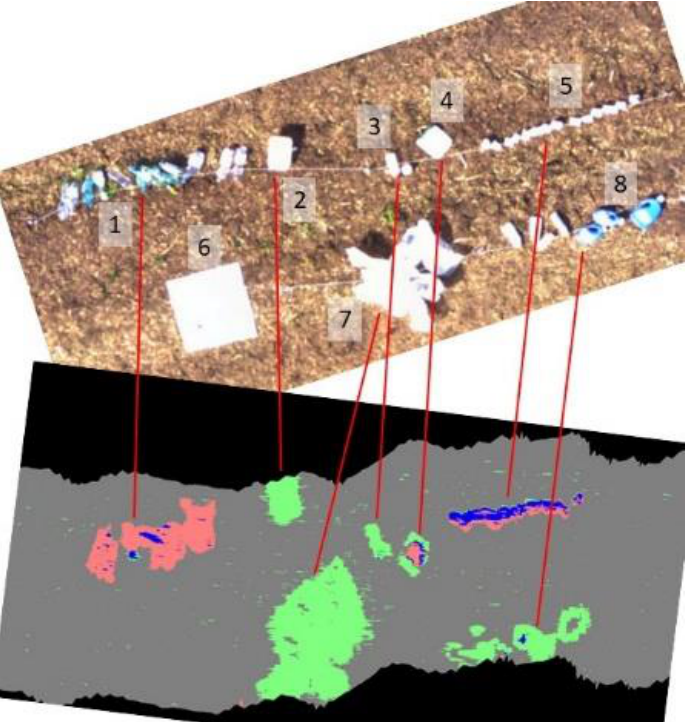
Figure 12. Detection of objects over bare earth: (1) PET bottles; (2) unknown plastics container; (3) Polypropylene (PP) containers; (4) unknown plastics container; (5) PP containers; (6) floor tile; (7) LDPE bags; (8) HDPE bottles. Color codes as in Figure 10.